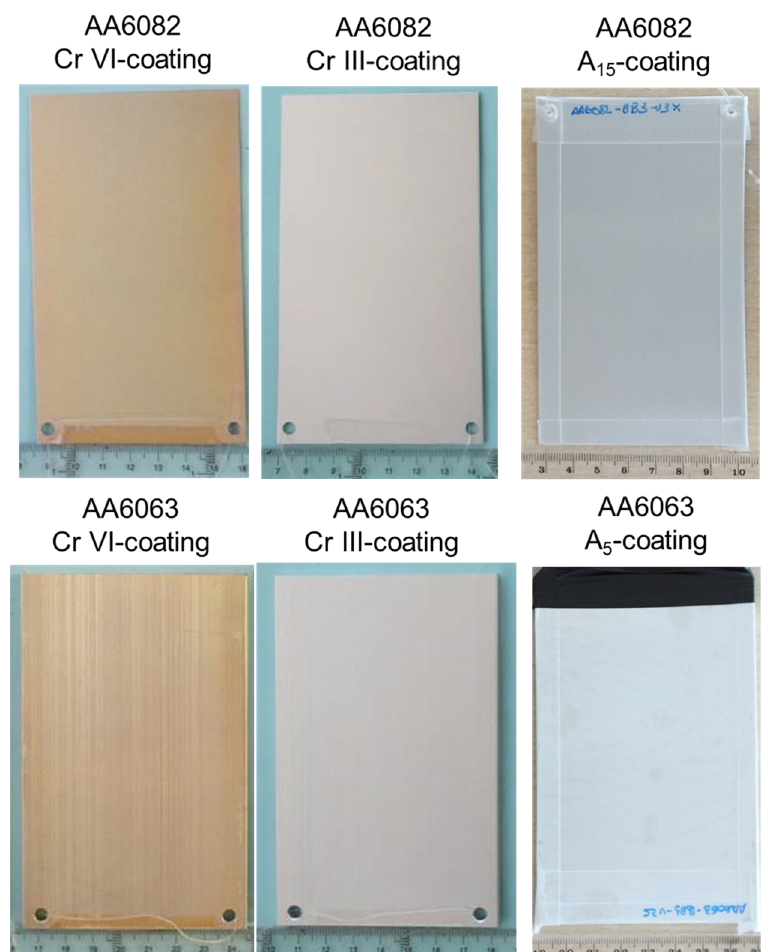
Figure 11. Representative photographs of AA6082 T6 (above) and AA6063 T6 (below) plates coated with Cr VI, Cr III and a coatings after 336 h of exposure to DHT.